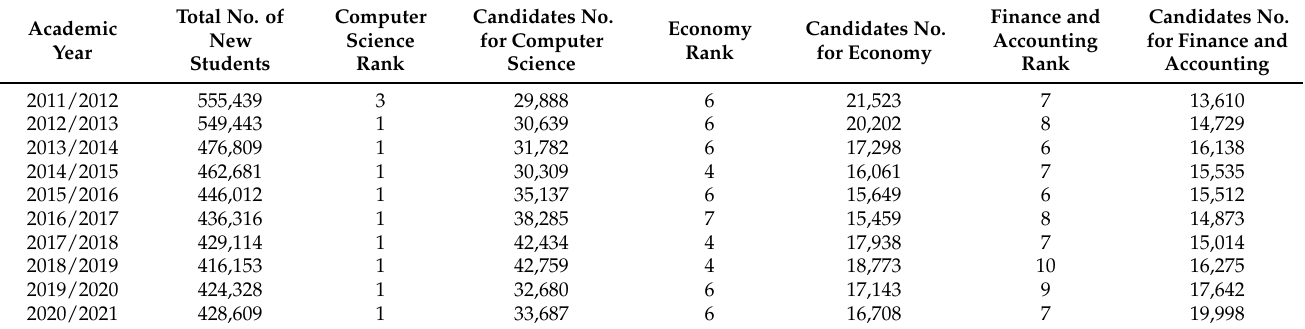
Table 5. Selected results of recruitment for higher education in 2011–2021. Showing the place in the popularity ranking and the number of candidates for Computer Science, Economics, Finance and Accounting field of study Total No. of Academic New Year